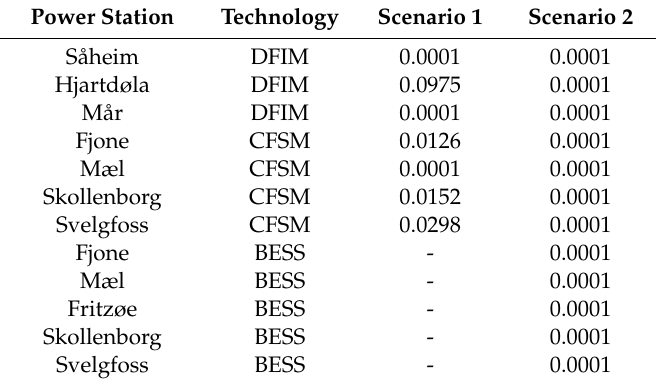
Table 11. Optimal droop coe ffi cients ( K d, α , K d, β and K d, γ ) of Scenario 1 and Scenario 2 in the year